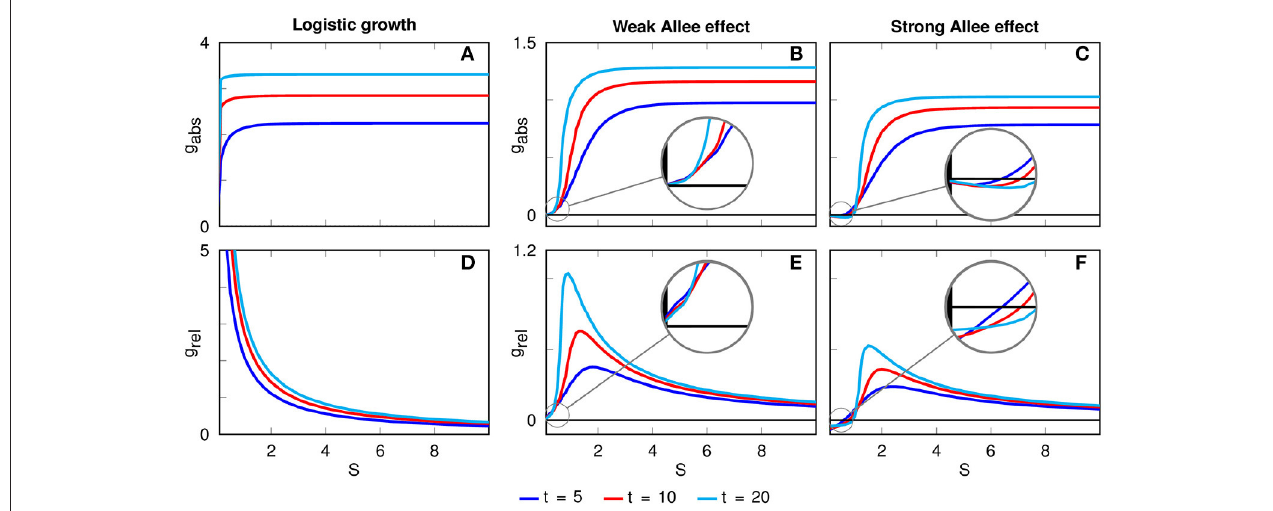
FIGURE 3 | Absolute (A–C) and relative (D–F) growth rates as functions of the patch width S for different time horizons. For logistic growth, the relative growth rate decreases with the initial patch width. In the presence of an Allee effect, there is an optimal patch width of maximal relative growth which depends on the considered time horizon. In the case of a strong Allee effect, the absolute and relative growth rates become negative for very narrow patches, leading to the extinction of the population on those